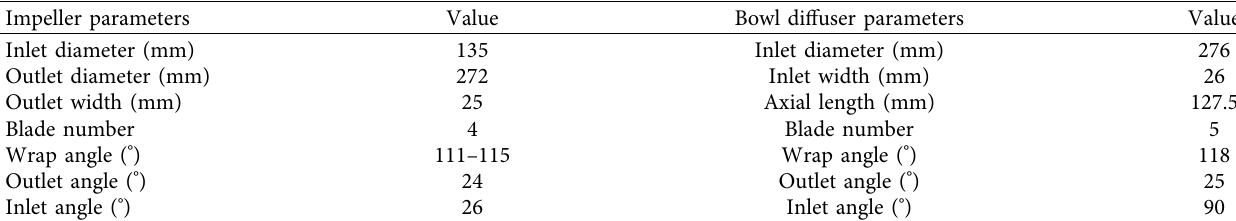
Table 1: Geometric parameters for the model slurry transport pump